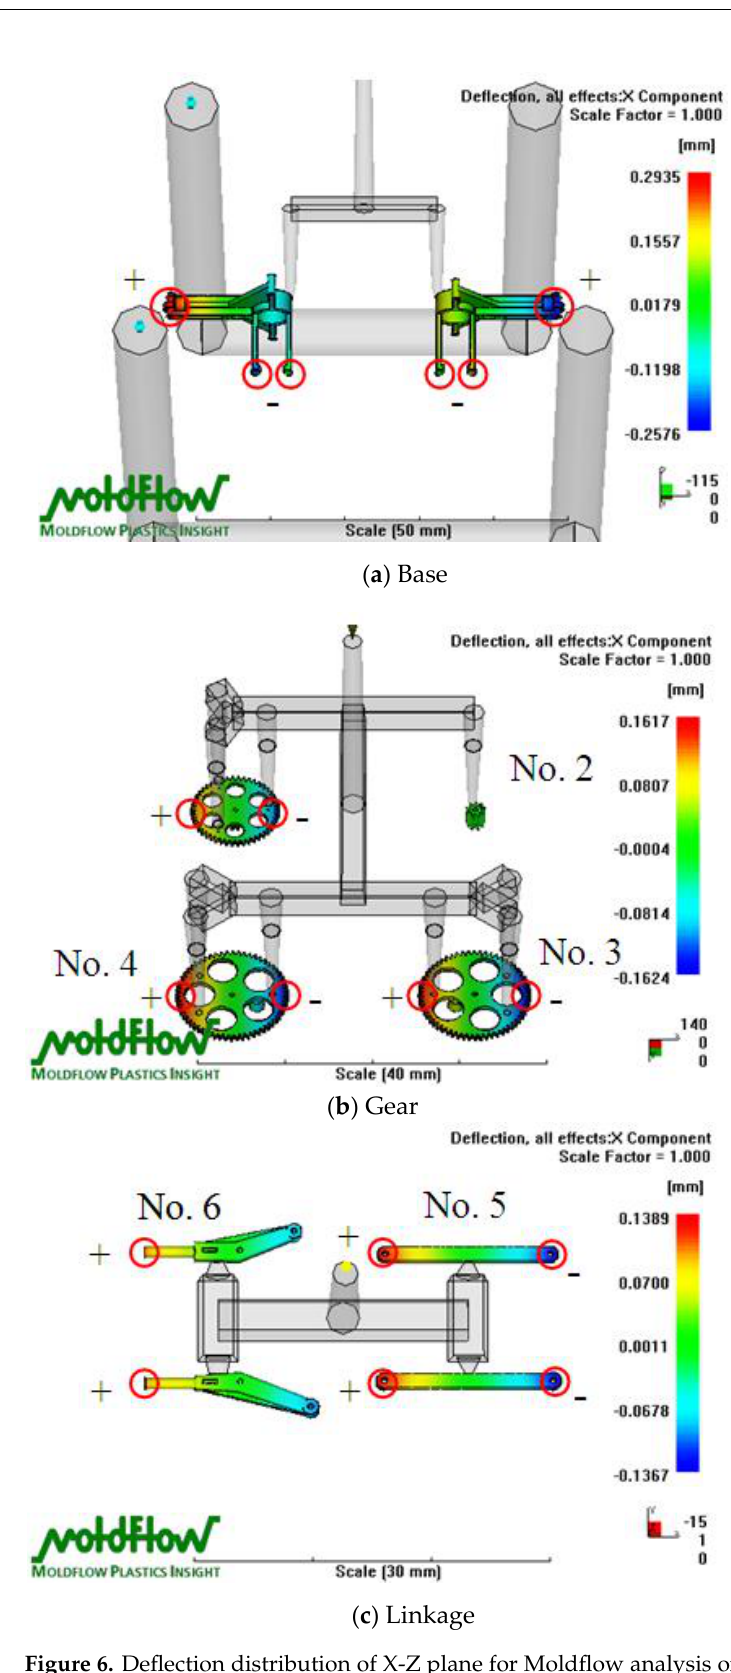
Figure 6. Deflection distribution of X-Z plane for Moldflow analysis on the flapping-wing MAV’s parts. *The red circle is the end point of the plastic flow front flowing into the mold cavity.